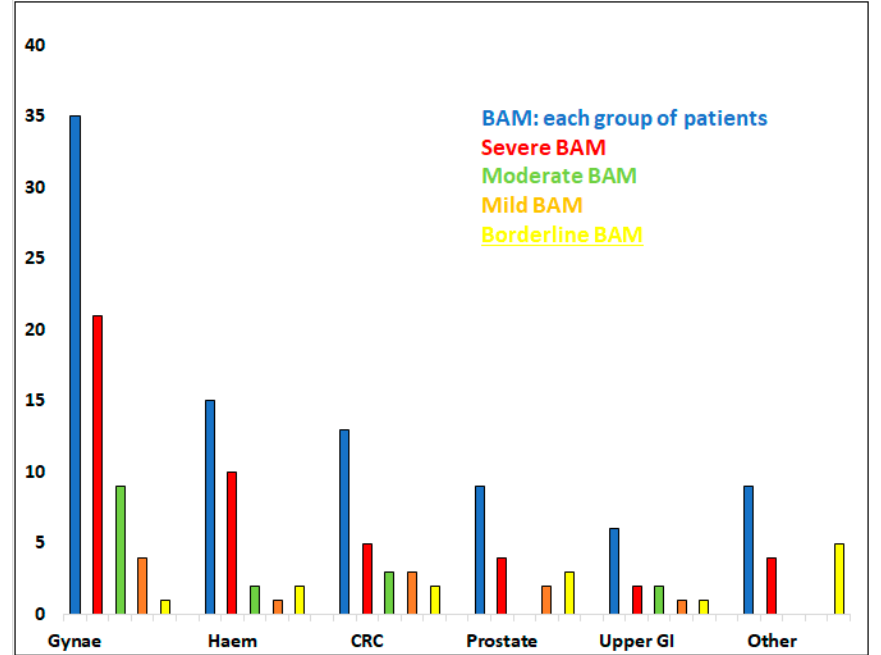
Figure 1. Patients with previous malignancy diagnosed with BAM (87 in total). Split into groups depending on original diagnosis: patients with gynaecological malignancy (Gynae; 35 patients); haematological diagnosis (Haem; 15); colorectal cancer (CRC; 13); prostate (9); upper gastro-intestinal malignancy (upper GI; 6) and other (8). Further, divided into sub- groups according to severity of BAM (severe, moderate, mild, borderline BAM). Severe form of BAM was observed most frequently in the haematology group (10/15; 67%) and the gynaecological group (21/35; 60%) of individuals, Table 1. Medication and low-fat diet were commenced in 65/87 (75%) patients, medication alone was recommended to 10/87 (11%) and diet alone to 6/87 (7%) individuals. Coleseve- lam was used in 71/75 (95%) and cholestyramine in 4/75 patients. No intervention followed in 6/87 (7%) patients: two suffered from constipation, symptoms of one individual resolved on morphine treatment (as a pain relief), two pa- tients were lost to follow-up (shortly after the diagnosis of BAM) and one individual took herbal medication. Symptoms improved in 74/87 (85%) patients, 6 individuals were lost to follow up or have not been assessed yet, symptoms of 7/87 (8%) patients have not improved. Vitamin D insufficiency (50–74 nmol/L) or deficiency (<50 nmol/L) were diagnosed in 62/82 (76%) of investigated patients; vitamin B12 deficiency (<239 pg/mL) was diag- nosed in 39/84 (46%) of investigated patients. 4. Discussion Group of patients who have received radiotherapy for malignancy in the pelvis and/or chemotherapy are in a high-risk developing BAM. The SeHCAT scan, regarded as the gold standard for diagnosis of BAM, was per- formed in 1981 for the first time [28]. The test is simple, non-invasive, well tolerated and involves minimal radiation. Currently, SeHCAT scan is available in Canada and 12